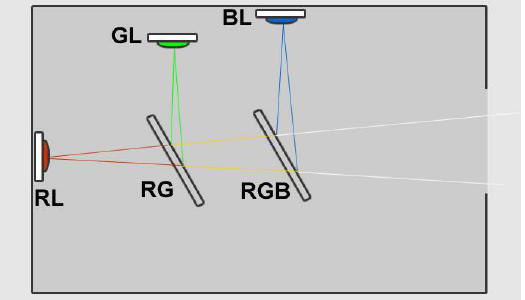
Figure 4. HoLoFoS TM optics head layout. RL, GL, BL: red, green, blue LEDs. RG: red-green combiner. RGB: red-green-blue combiner.